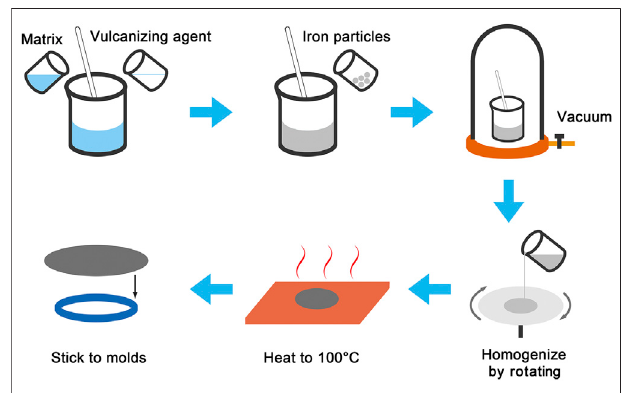
FIGURE 1 | Schematic diagram of the material preparation